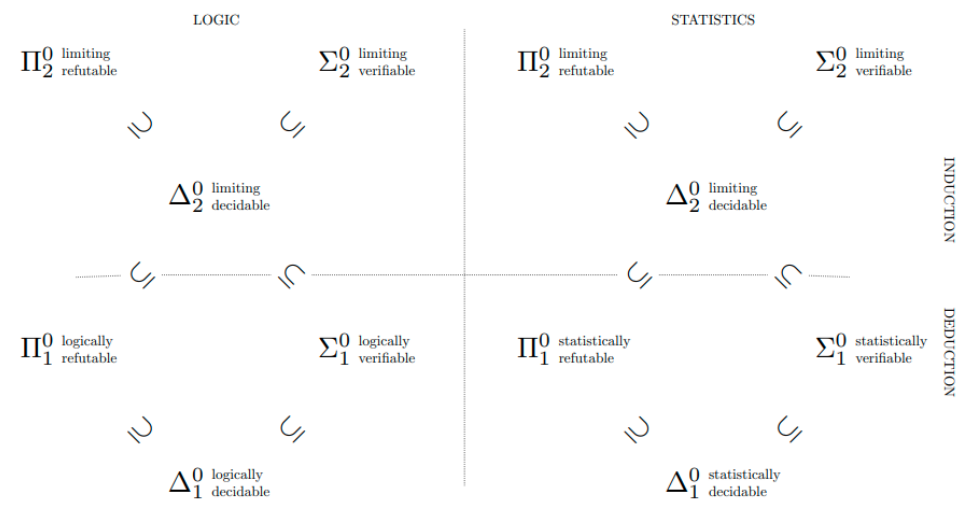
Figure 1. Pictured is a hierarchy of topological complexity and corresponding notions of methodolog- ical success. The set of all open sets is referred to as Σ 0 ; the set of all closed sets as Π 0 ; and the set of 1 1 = Σ 0 ∩ Π 0 all clopen sets as ∆ 0 . Depending on whether the Σ 0 sets are propositions of type V1 or V2, 1 1 1 1 we get the logical ( left ) and statistical ( right ) hierarchies. Sets of greater complexity are built out of Σ 0 1 sets by logical operations, e.g., Σ 0 sets are countable unions of locally closed sets. Inclusion relations 2 between notions of complexity are also indicated. For more on the notions of methodological success characterized by higher levels of Borel complexity, see Genin and Kelly